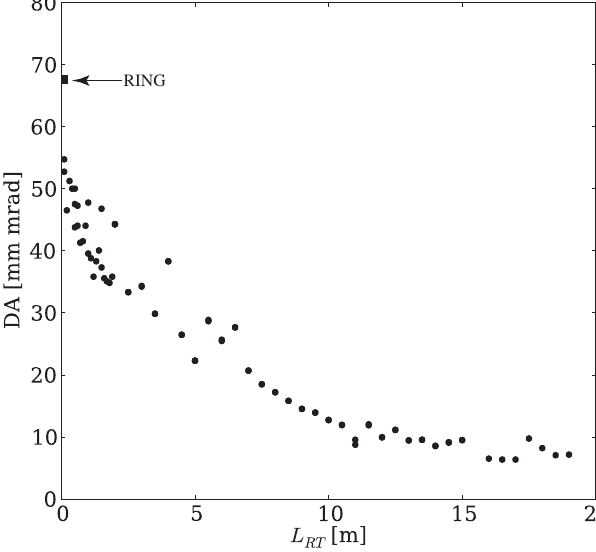
FIG. 12. The DA for racetracks as a function of L RT is shown. The DA for the NORMA ring lattice can be seen at L RT ¼ 0